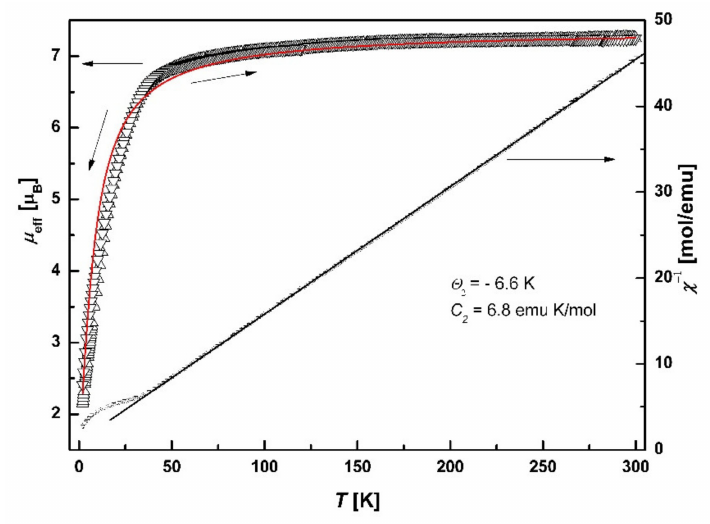
Figure 13. The temperature dependences of the effective magnetic moment, µ eff , and the inverse magnetic susceptibility, χ –1 , for 2 . The solid line corresponds to the Curie–Weiss fit with Θ 2 = − 6.6 K. The solid red line represents the best fit within the Bonner–Fisher model for HS chains ( J 2HS = − 1.8 K), including PM